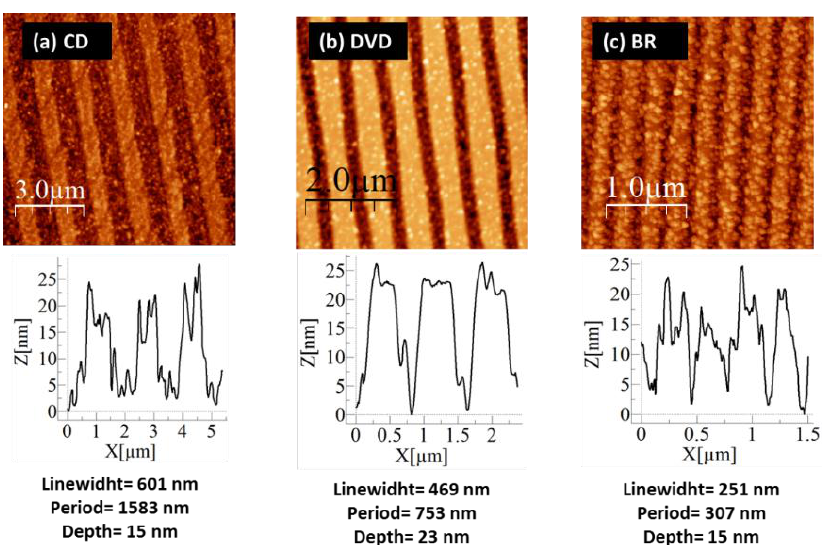
Figure 2. Atomic force microscope (AFM) images of ordered 1D nanostructures on glass. ( a ) Compact disc (CD) sample. ( b ) Digital versatile disc (DVD) sample. ( c ) Blu-ray disc (BR) sample.